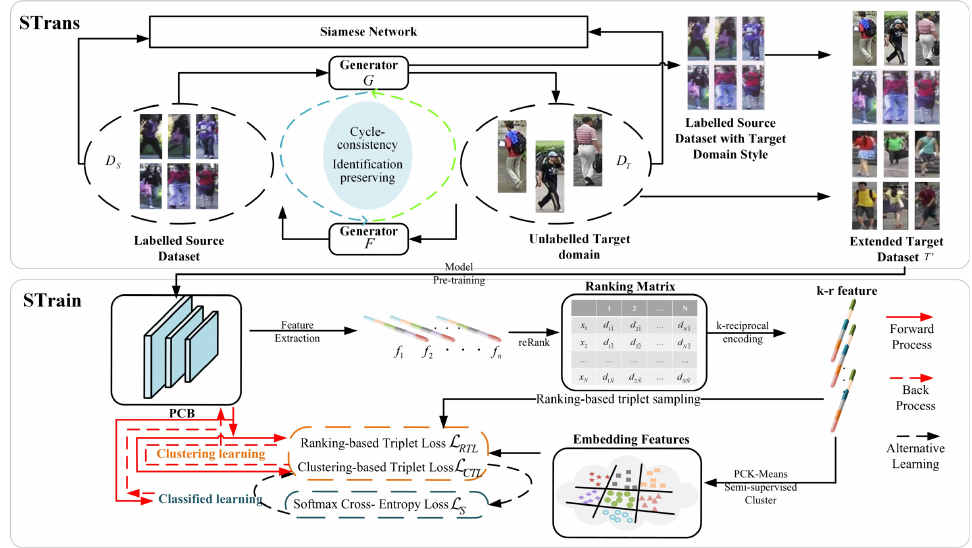
Figure 4. The framework of the proposed